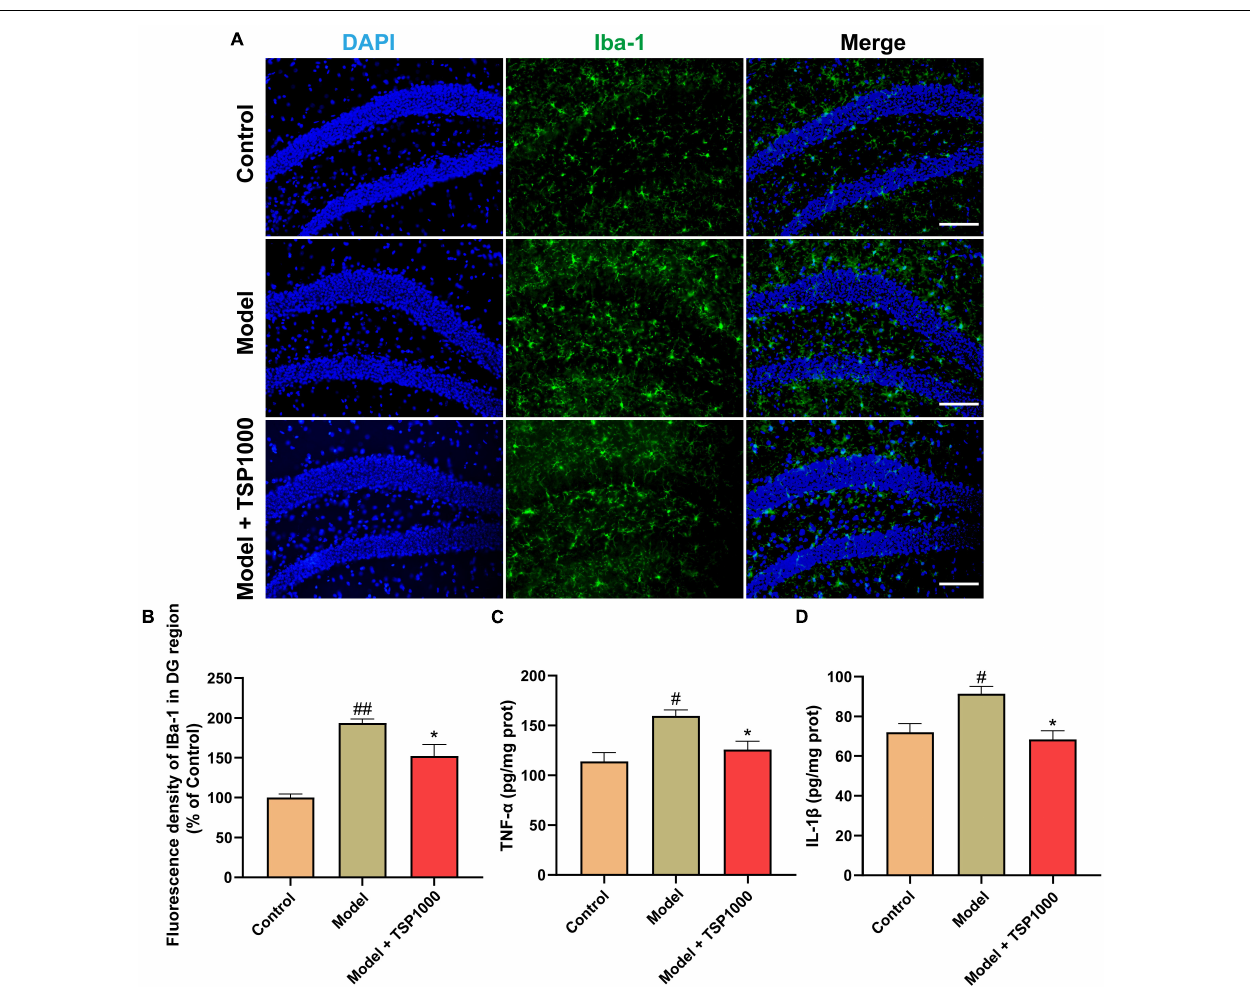
Frontiers in Nutrition |